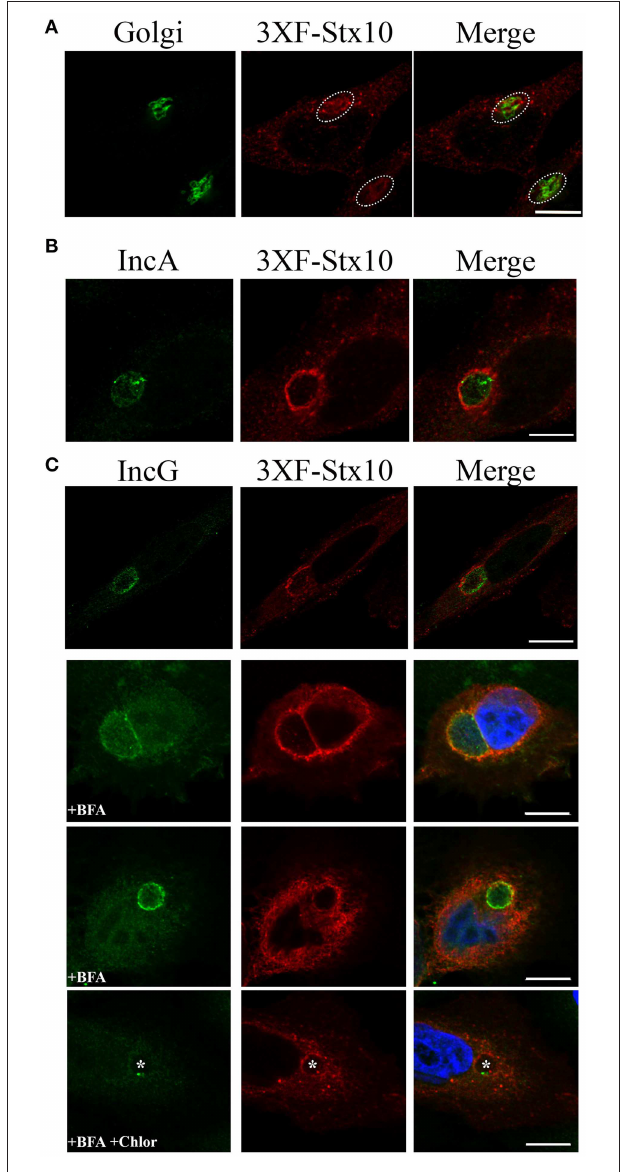
FIGURE 1 | Syntaxin 10 localization to the chlamydial inclusion. (A) HeLa cells were transfected with 3XFLAG-syntaxin 10 (3XF-stx10) for 24h prior to fixation and processing for imaging. The Golgi (outlined in white) was detected with a rabbit anti-giantin antibody; 3XF-Stx10 was detected using a mouse anti-FLAG M2 antibody. (B,C) HeLa or HEp2 cells transfected with 3XF-stx10 were infected for 16–18h with C. trachomatis serovar L2, prior to fixation and processing for imaging. The inclusion membrane was detected using either a rabbit anti- IncA (B) (Additional images provided in Supplemental Figure 1) or IncG (C) antibody; 3XF-Stx10 was detected as above. To distinguish 3XF-Stx10 from surrounding cell structures, some samples were treated with brefeldin A (BFA) to collapse the surrounding Golgi. To examine if chlamydial protein synthesis was required for 3XF-Stx10 localization, infected monolayers were treated with 200 µ g/ml chloramphenicol (Chlor) for an additional 24h prior to fixation. In chloramphenicol treated cells, white asterisks indicate inclusions. All images were acquired using an Olympus Fluoview 1000 Laser Scanning Confocal Microscope with a 60X objective and 2x zoon. These results are representative of at least 3 independent experiments. White bars = 10 µ